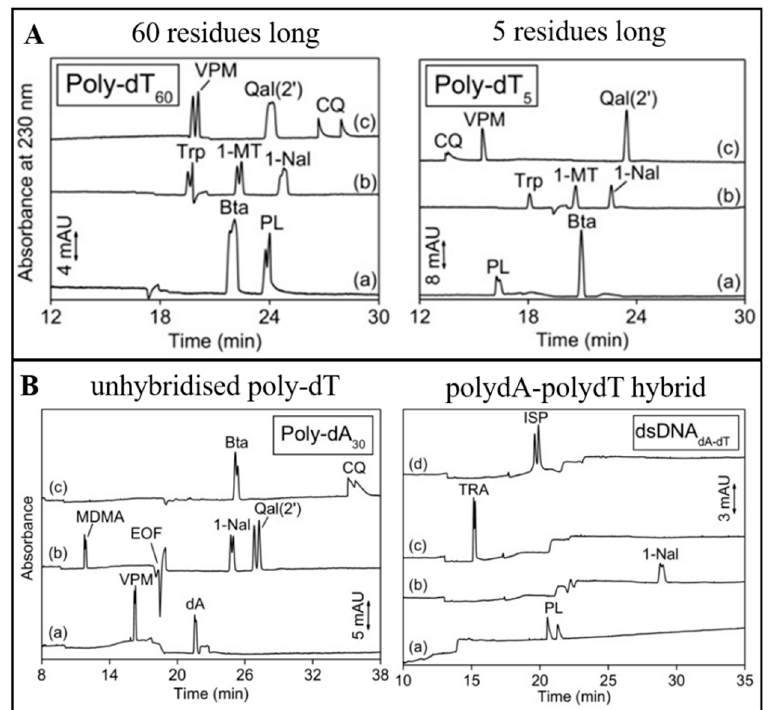
Figure 4. ( A ) Effect of number of oligonucleotide residues (60 vs. five residues) on PF-EKC separation. ( B ) Effect of oligonucleotide hybridisation (unhybridised vs. hybridised) on PF-EKC separation. Conditions: fused silica capillary 105 cm (60 cm to the detector) × 25 μ m i.d., applied voltage: + 30 kV, temperature: 10 °C, electrolyte: ( A ) 70 mM Tris + 56 mM HCl + 140 mM NaCl (pH 7.5), ( B ) 57.5 mM Tris + 46 mM HCl + 115 mM NaCl (pH 7.5), PF solution: (A) Poly-dT 60 at 0.46 mM, Poly-dT 5 at 5.11